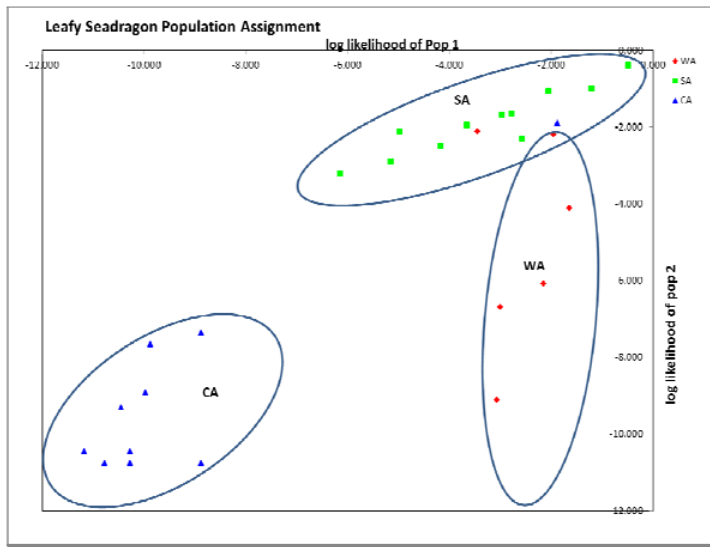
Figure 1. GenAlEx assignment plot showing distinct clustering of all three sampled groups. 96% assigned to the population of origin. Note assignment of 1 captive animals (CA) animals and 2 Western Australia (WA) animals assigned within Southern Australia (SA). Axes are log likelihoods of population assignment.